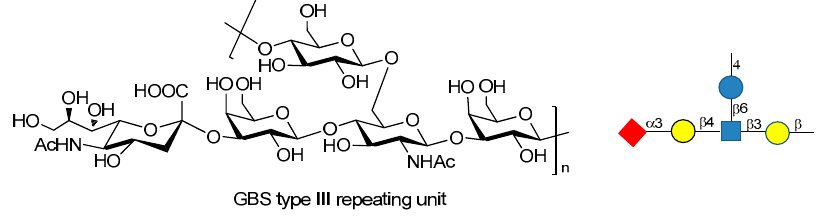
Figure 19. GBS PSIII repeating unit.